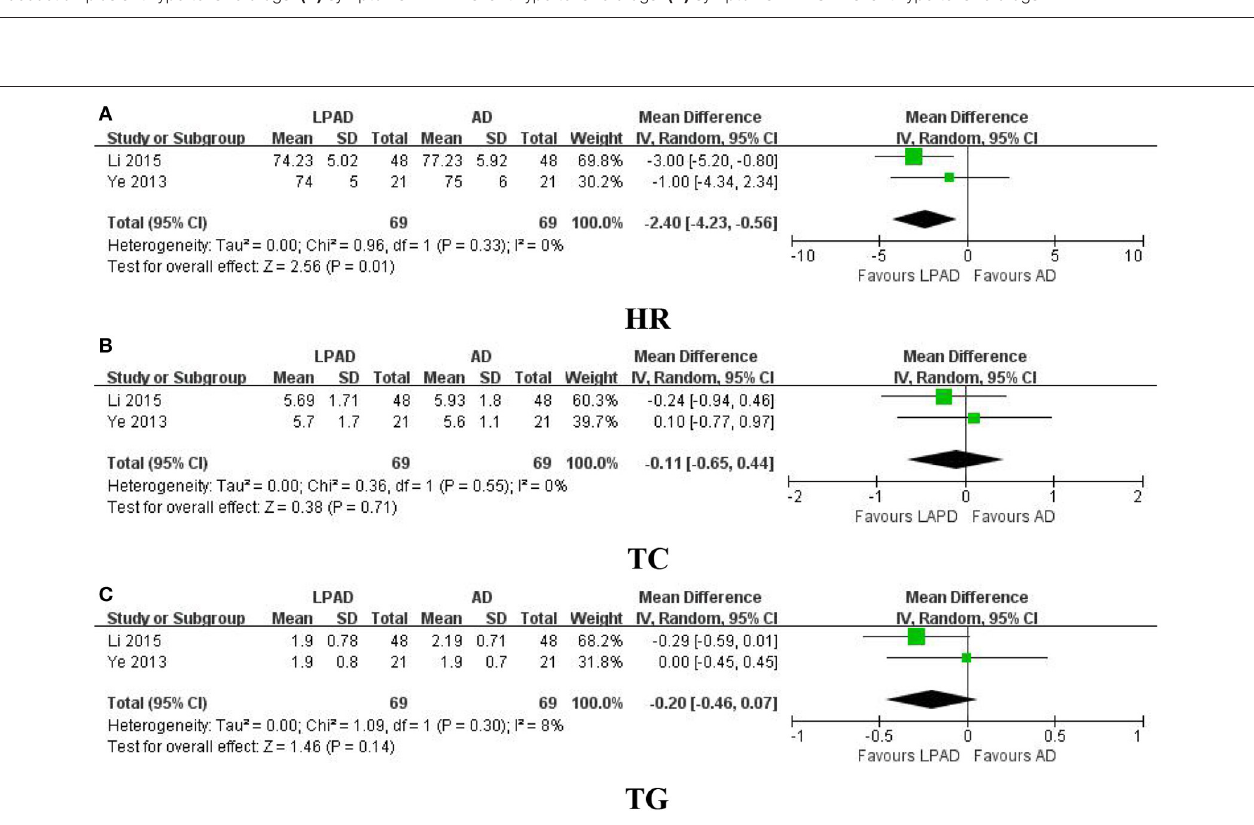
FIGURE 5 | Forest plots of the comparison of LPAD vs. antihypertensive drugs for the outcomes of (A) HR, (B) TC, and (C) TG. AD, antihypertensive drugs; HR, heart rate; LPAD, longdanxiegan decoction plus antihypertensive drugs; TC, total cholesterol; TG, triglycerides.